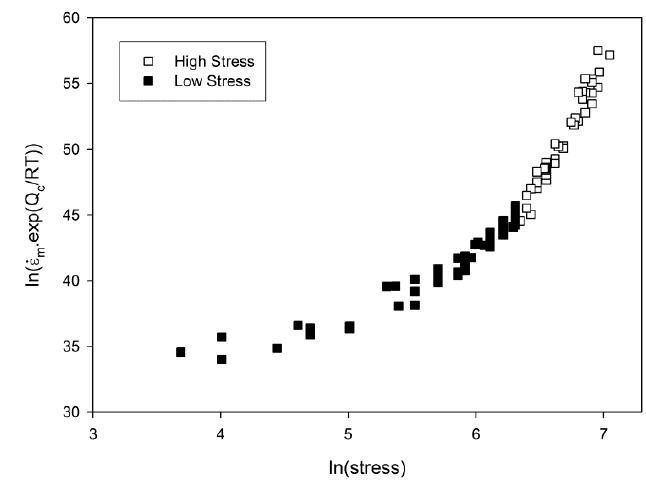
Figure 4. The relationship between ln(stress) and ln( ε(cid:4662) m ·exp(Q c /RT)) in Waspaloy. Q c * = 500 KJ/mol.